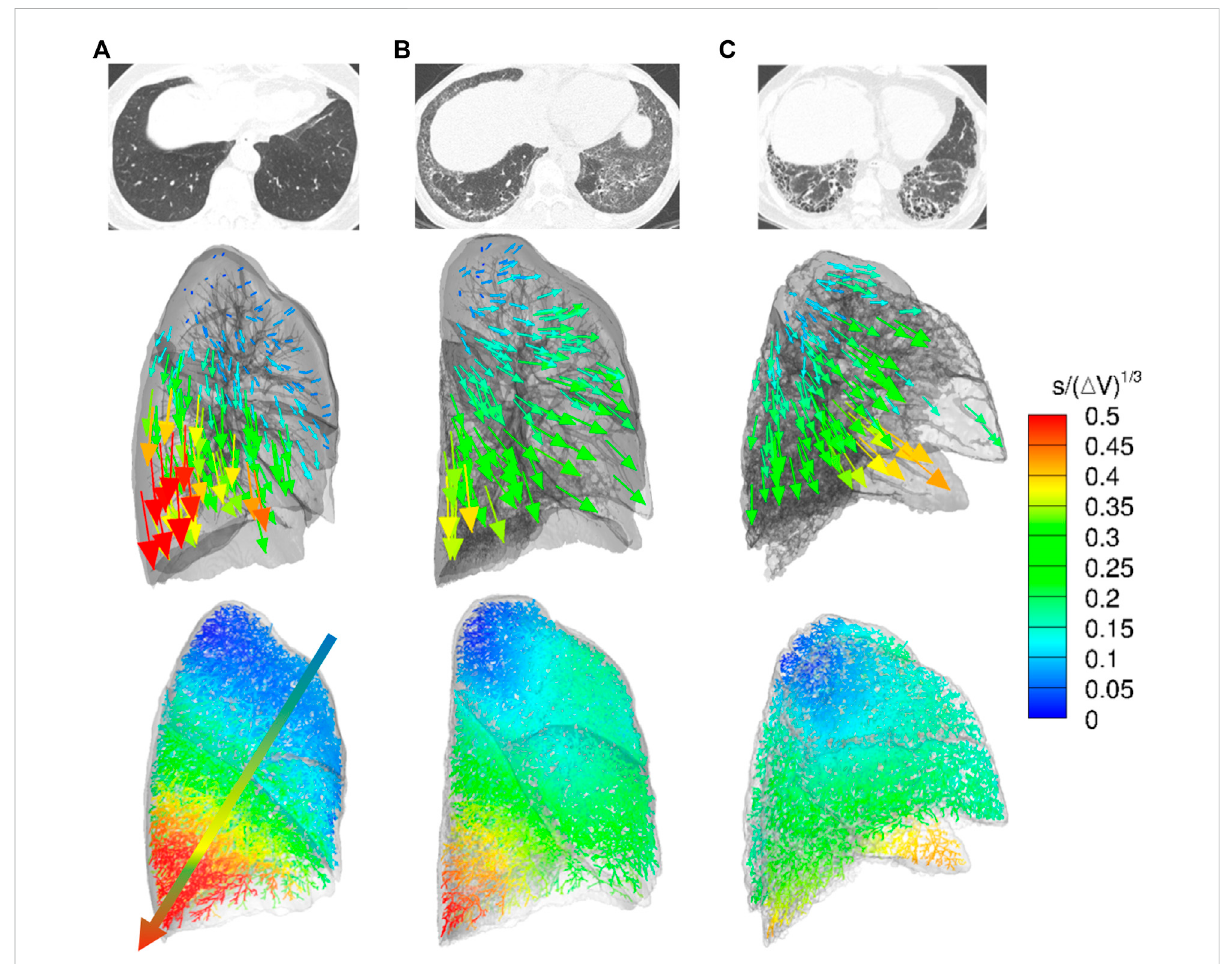
FIGURE 2 CT axial views (top), displacement vectors from expiration to inspiration (middle), and normalized dorsal and basal displacement magnitude maps on the entire conducting airway model (bottom) in representative (A) normal, (B) NSIP, and (C) UIP